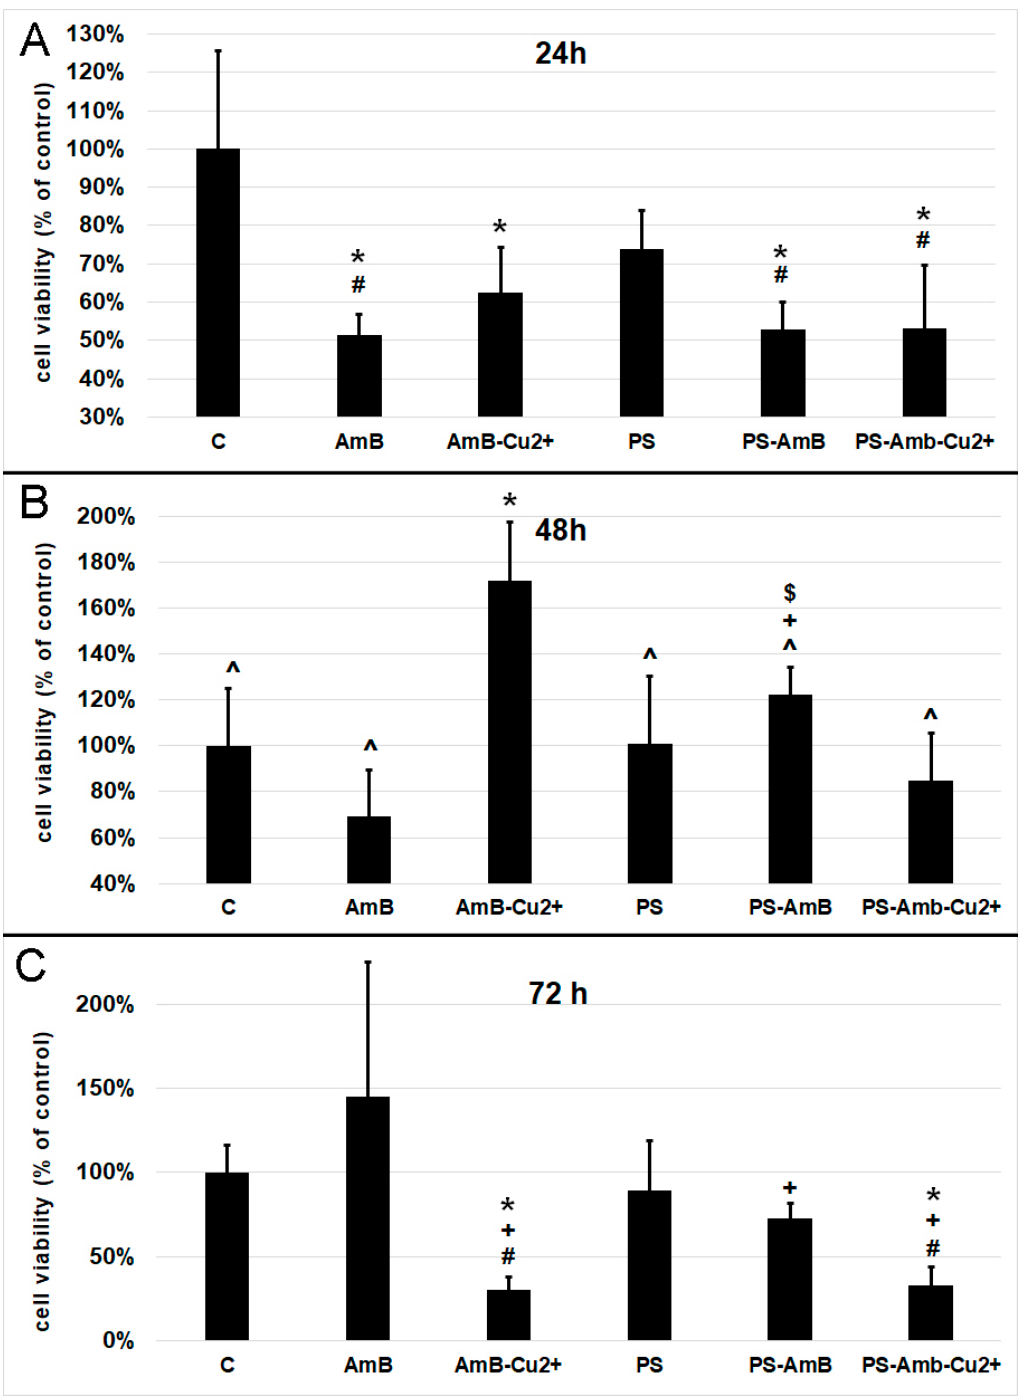
Figure 1. Cell viability based on the measurement of total cellular protein content after exposure to the tested antibiotics and their combinations for 24 ( A ), 48 ( B ) and 72 h ( C ). The bars represent the means ± standard deviation (SD) of the percentages of the control cell viability (100%); analysis of variance (ANOVA) with the Tukey post hoc test, * p < 0.05 vs. control, # p < 0.05 vs. PS, ^ p < 0.05 vs. AmB-Cu 2+